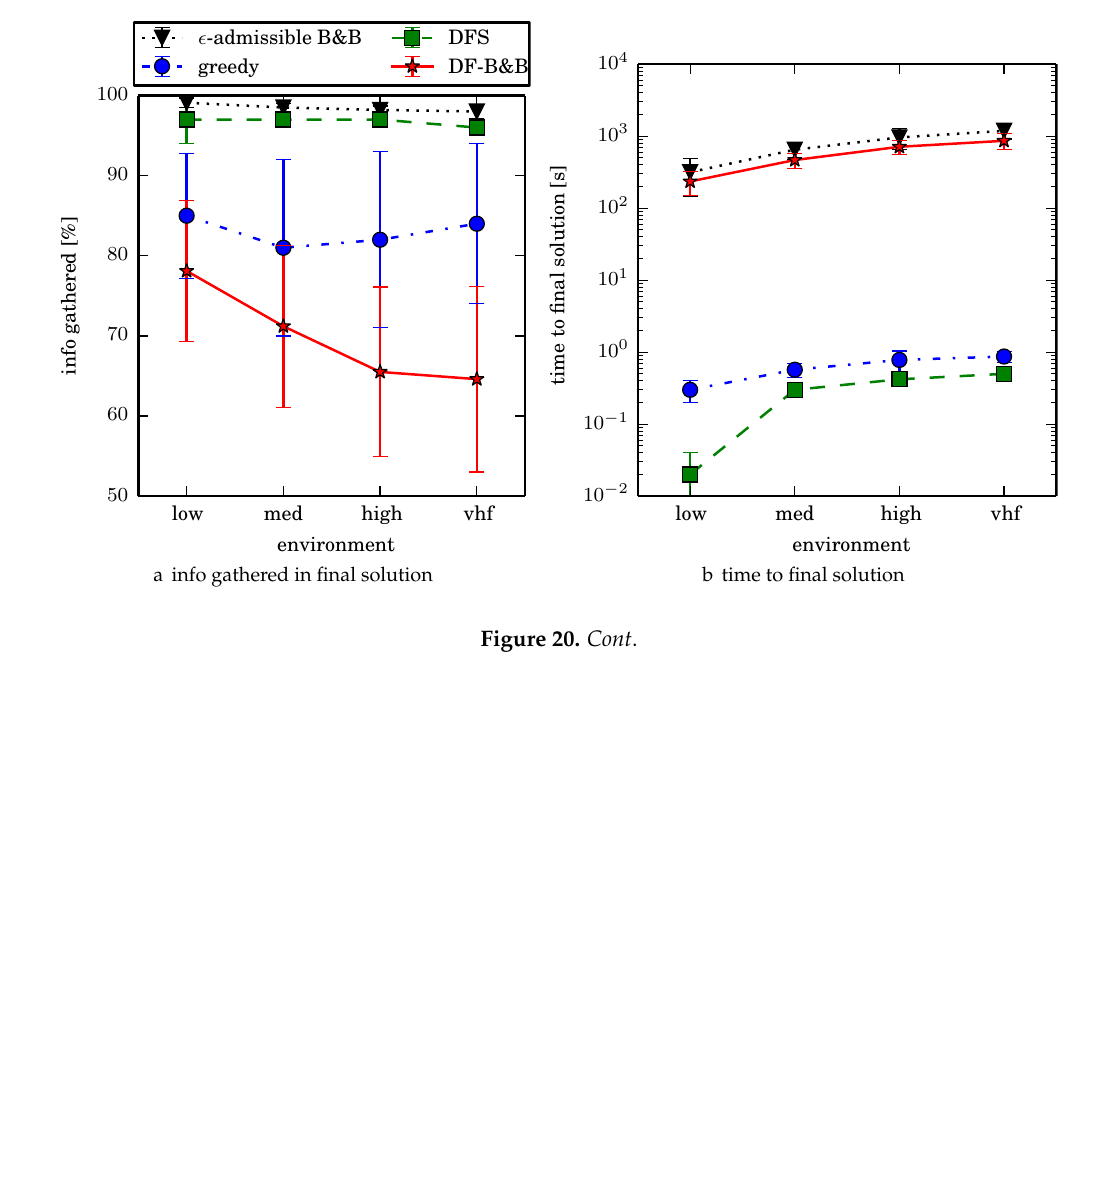
Figure 19. Multipass coverage plans in environments with nonuniform information for the DF-B&B coverage planner algorithm.